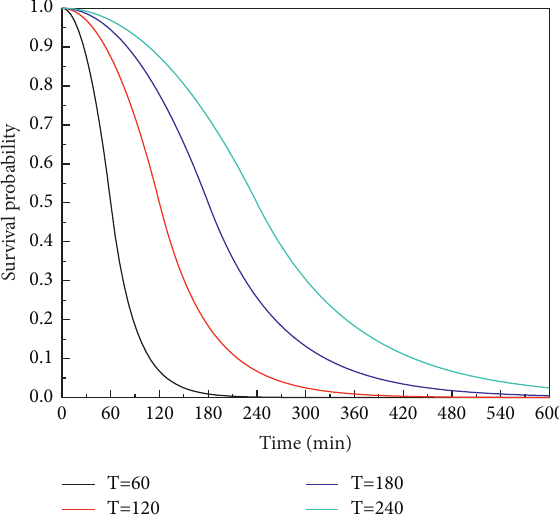
Figure 9: Function of survival probability and time.